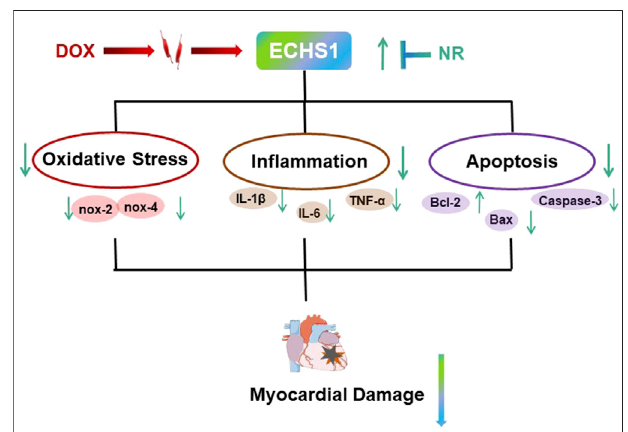
FIGURE 6 | Schematic diagram of the